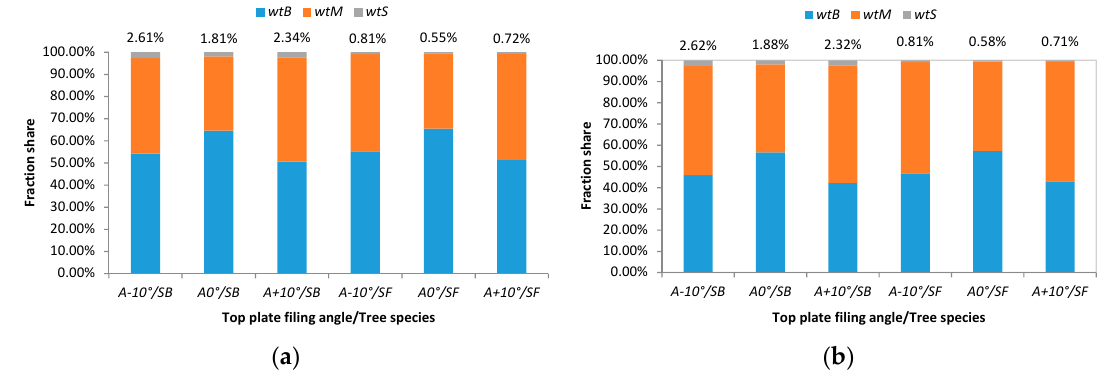
Figure 2. Dependency of sawdust weight structure on top plate filing angle ( A ) and tree species ( S ): ( a ) chain producer 1 and ( b ) chain producer 2. Note: wtB —big particles (more than 3 mm), wtM —medium-sized particles (3–0.125 mm) and wtS —small (inhalable) particles (less than 0.125 mm).